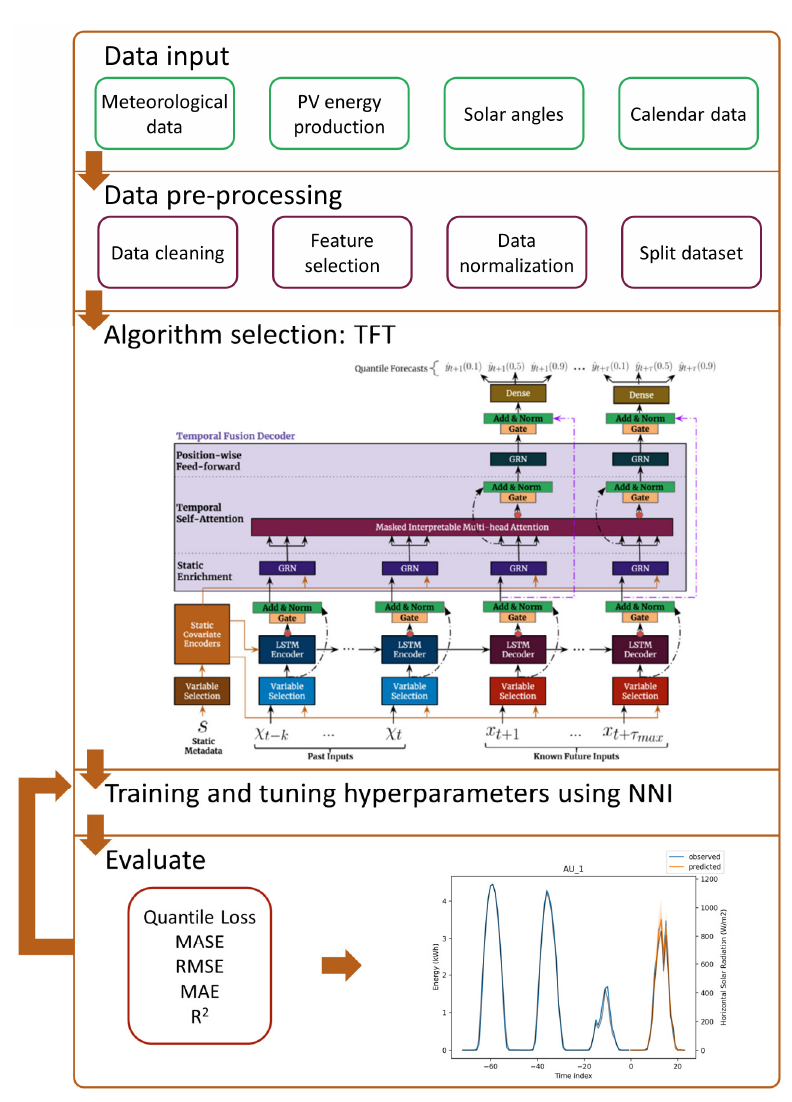
Figure 2. Structure of the proposed model. TFT architecture was adapted from [50].